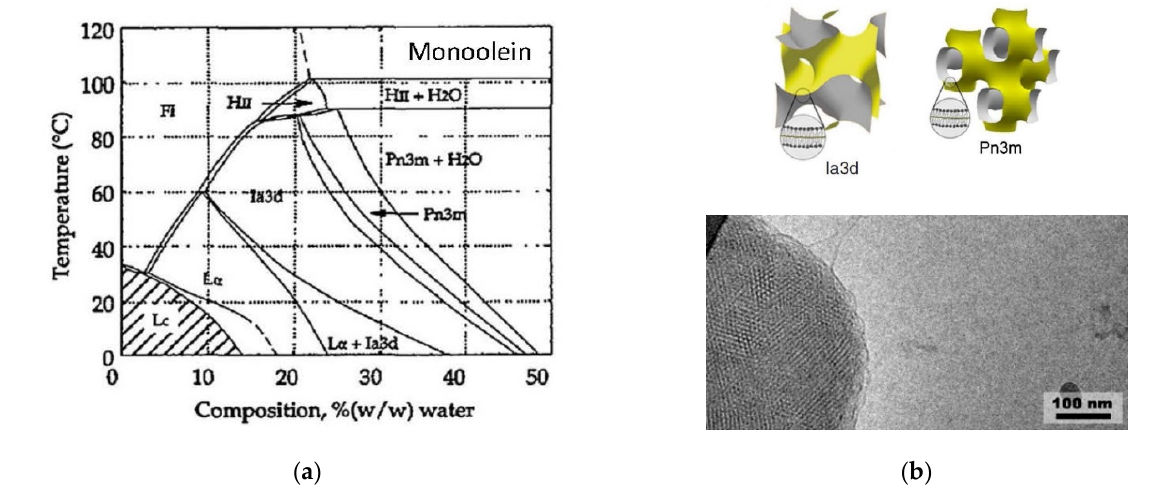
Figure 6. Monoolein cubic phases and cubosomes. ( a ) Binary monoolein/water phase diagram, indicating the localization of the inverse bicontinuous cubic phases Ia3d and Pn3m, the lamellar phase L α , the inverse hexagonal phase H II , the fluid isotropic phase FI, the lamellar crystalline phase Lc, and the corresponding coexistence regions (two phases), as published by Briggs et al. (1996) [76]; ( b ) Top : Schematic representation of the arrangement of amphiphilic lipids in the cubic phases Ia3d and Pn3m; see Koynova and Tenchov (2013) [58] or Tenchov and Koynova (2017) [78]. The polar head groups of the amphiphiles point towards the internal water channels. Bottom : cryo-TEM image of dispersed monoolein cubic phase Pn3m in water (2 wt% monoolein, 98 wt% D 2 O; bar: 100 nm) [79]. The structured area on the left-hand side is dispersed Pn3m, present as cubosome particles. Reproduced with permission from [76], EDP Sciences, 1996; from [78], Elsevier, 2017; and from [79], Elsevier, 2003.